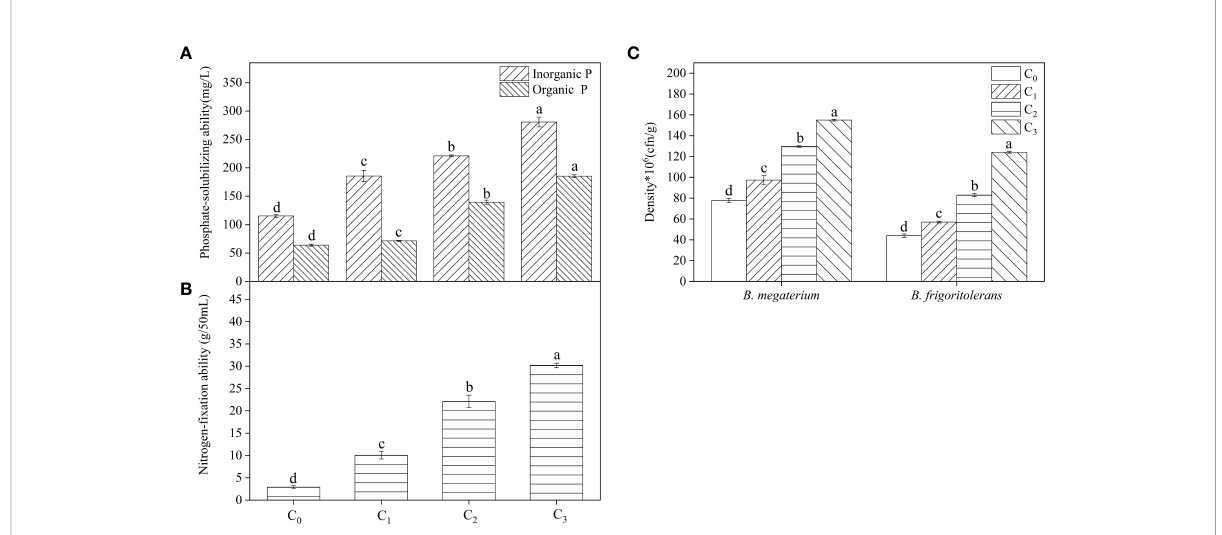
FIGURE 2 The effect of root exudates on the phosphate-solubilizing ability of B . frigoritolerans (A) and the nitrogen- fi xation of B . megaterium (B) and their densities (C) . C 0 , sterile water; C 1 , 20×the volume of concentrated root exudates; C 2 , 40×the volume of concentrated root exudates; C 3 , 60×the volume of concentrated root exudates. Different lowercase letters above the data bar indicate that the strain with different concentrations root exudates has signi fi cant differences at the p < 0.05 level. The “ * ” indicated that density of the Bacillus strains multiplied by 10 6